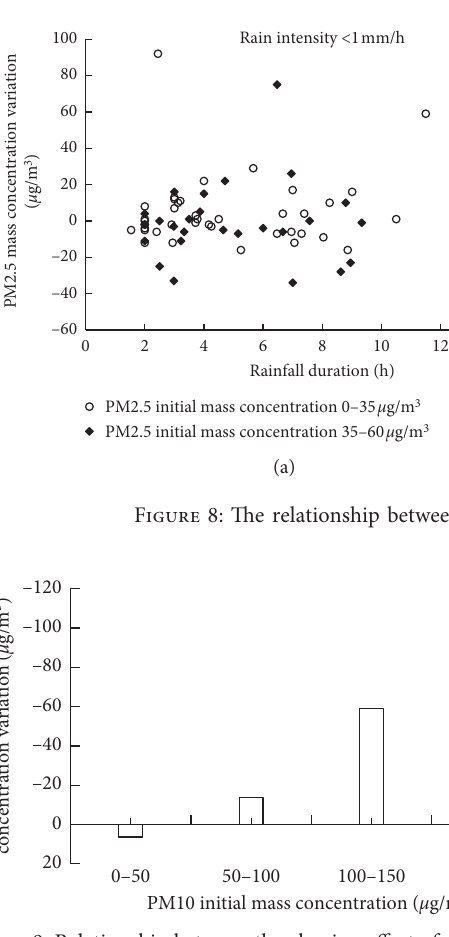
Figure 9: Relationship between the clearing effect of precipitation on PM10 and the initial concentration of